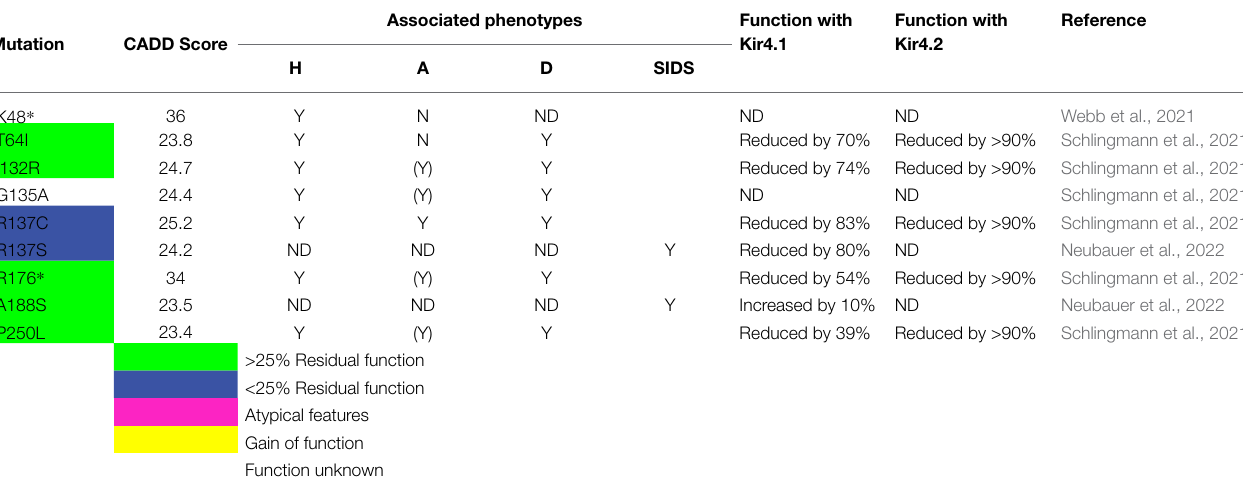
Table 2 summarizes the consequences of KCNJ16 mutations. CADD score according to https://cadd.gs.washington.edu/snv (Rentzsch et al., 2019). Associated phenotypes refer to hypokalemia (H), acidosis (A), sensorineural deafness (D), and a possible association with sudden infant death syndrome (SIDS). Yes (Y); probably Yes (Y); No (N); Not examined (ND). Color code is shown for functional effects when coexpressed with Kir4.1. * indicates a “stop codon”. Note that functional consequences were generally more severe when Kir5.1 mutants were coexpressed with Kir4.2 (Schlingmann et al.,